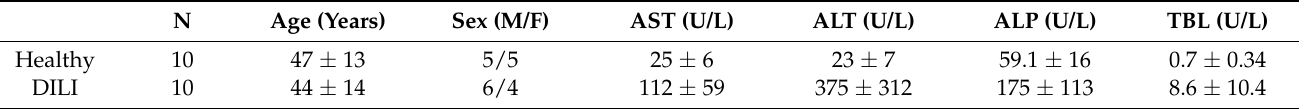
Table 1. Clinical characteristics of drug-induced liver injury (DILI) patients compared to healthy